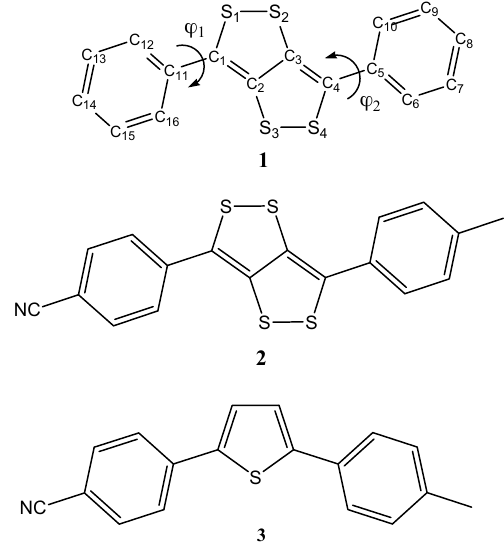
Scheme 1. Schematic representation of the investigated compounds 1 – 3 .